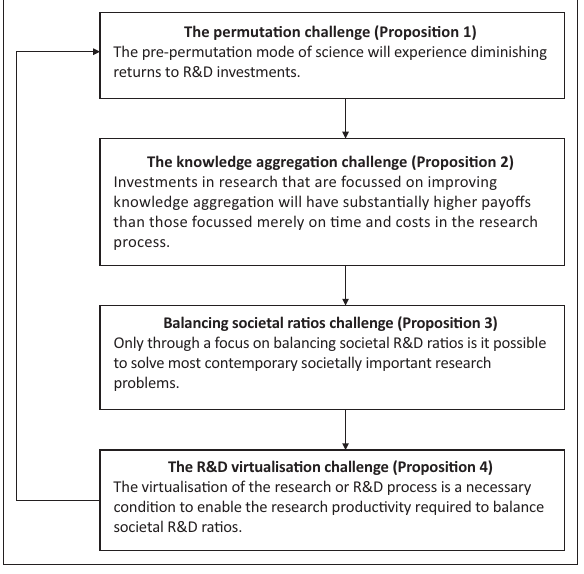
R&D, research and development. FIGURE 2: Necessary conditions for solving contemporary societally important research problems.